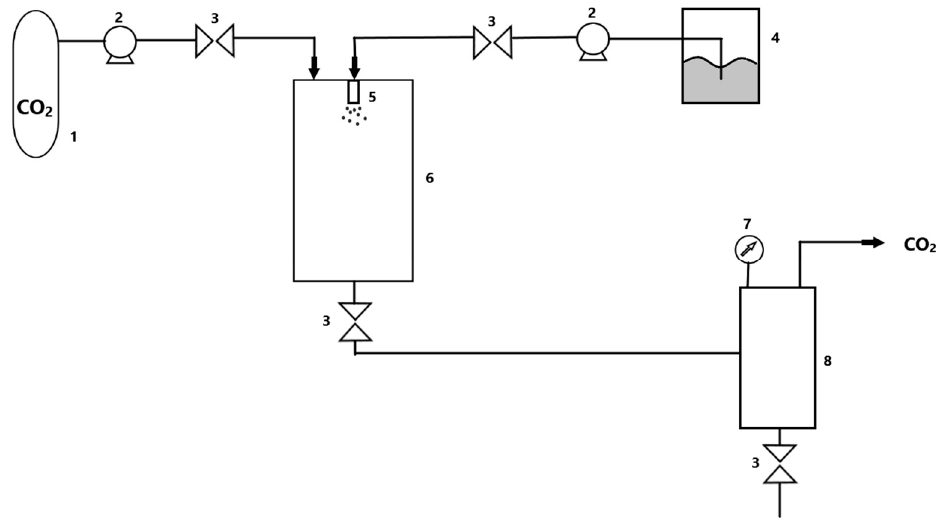
Figure 5. Aerosol solvent extraction system (ASES) process installation diagram. Legend: (1) CO 2 tank; (2) pump; (3) valve; (4) active substance solution; (5) nozzle; (6) high-pressure tank; (7) temperature control; (8) low-pressure tank.